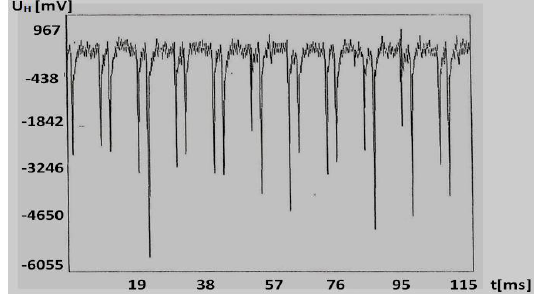
Figure 16. Hall voltage versus time in the case of breaking the rotor winding integrity, Hall sensors fixed on the stator, unloaded starter.